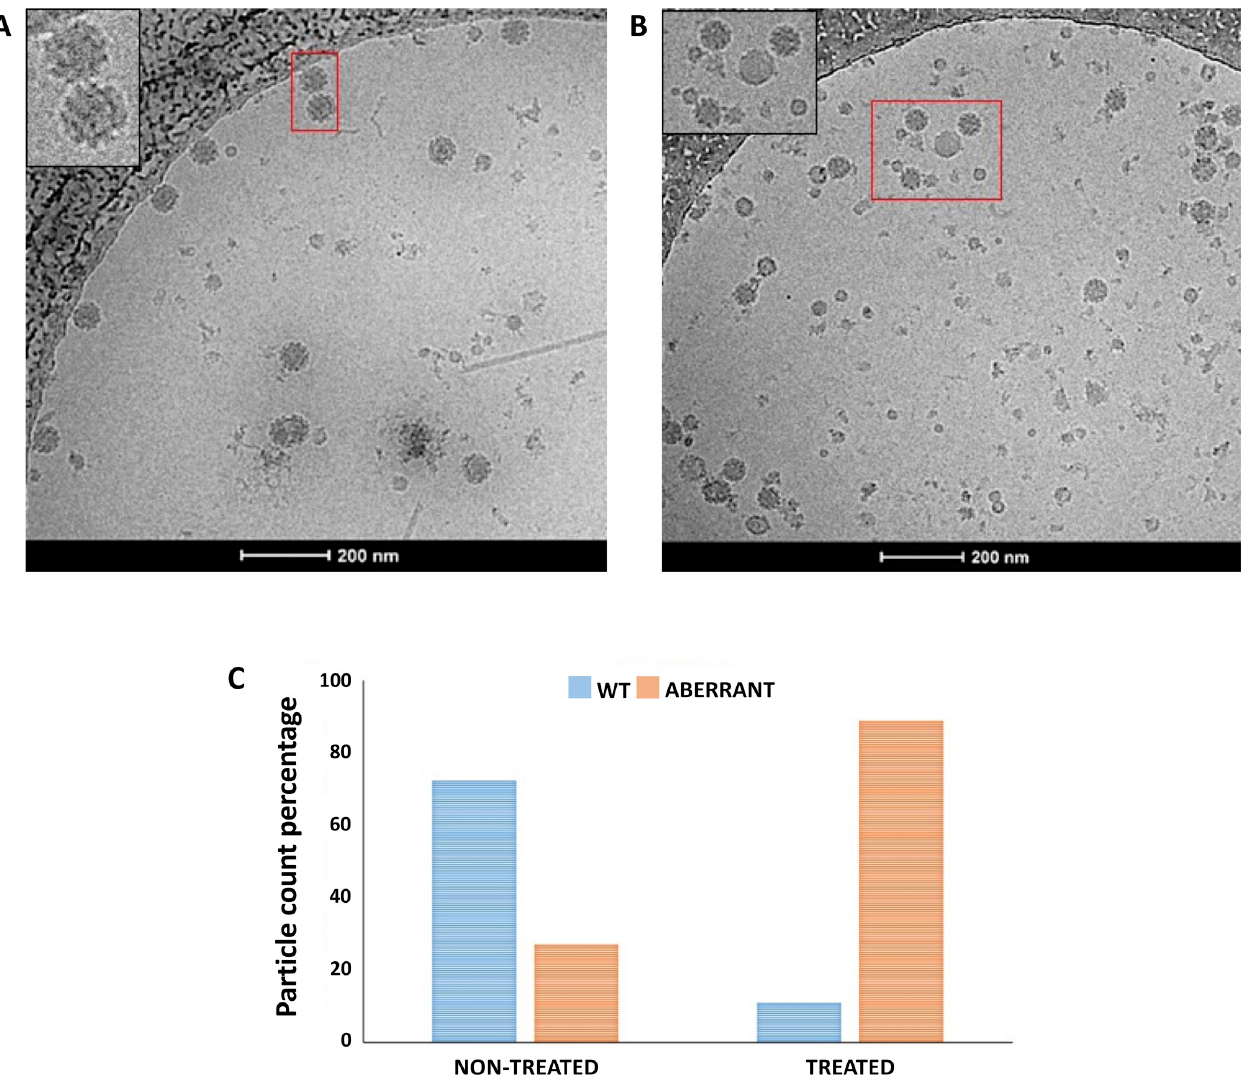
Fig 7. Amantadine treatment alters CHIKV VLP particle morphology: Cryo-electron micrographs of CHIKV VLPs generated from (A) untreated and (B) amantadine treated HEK293T cells transfected with the CHIKV structural cassette. (C) A histogram plot of wild type and aberrant CHIKV particles counted from cryo-micrographs as in (A) and (B) shows the relative abundance of the two species.